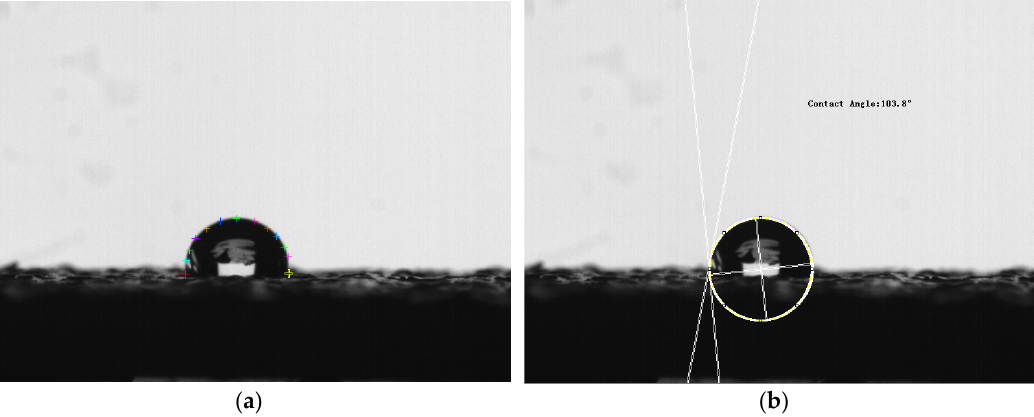
Figure 8. Measurement of contact angle. ( a ) Manual contour extraction; ( b ) measured contact angle.